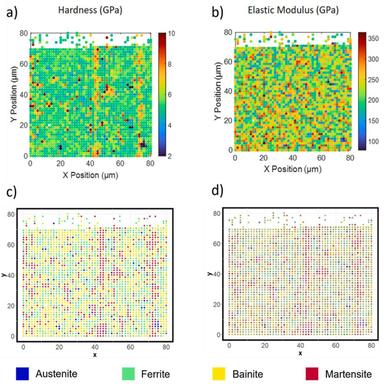
Nanoindentation scatter plots: (a) hardness map, (b) indentation modulus map, (c) phase map, (d) overlayed nanoindentation phase scatter map with EBSD (2519 data points in total). X and Y coordinates are presented in µm.